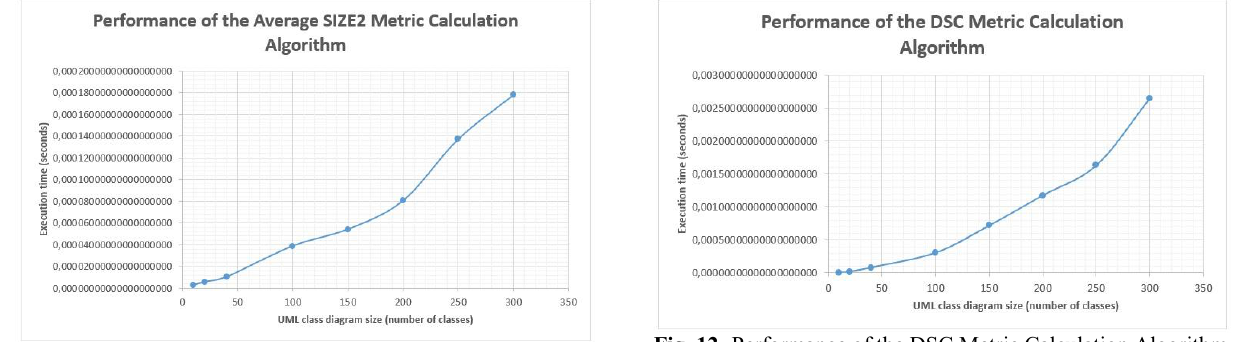
Fig. 11. Performance of the Average SIZE2 Metric Calculation Algorithm